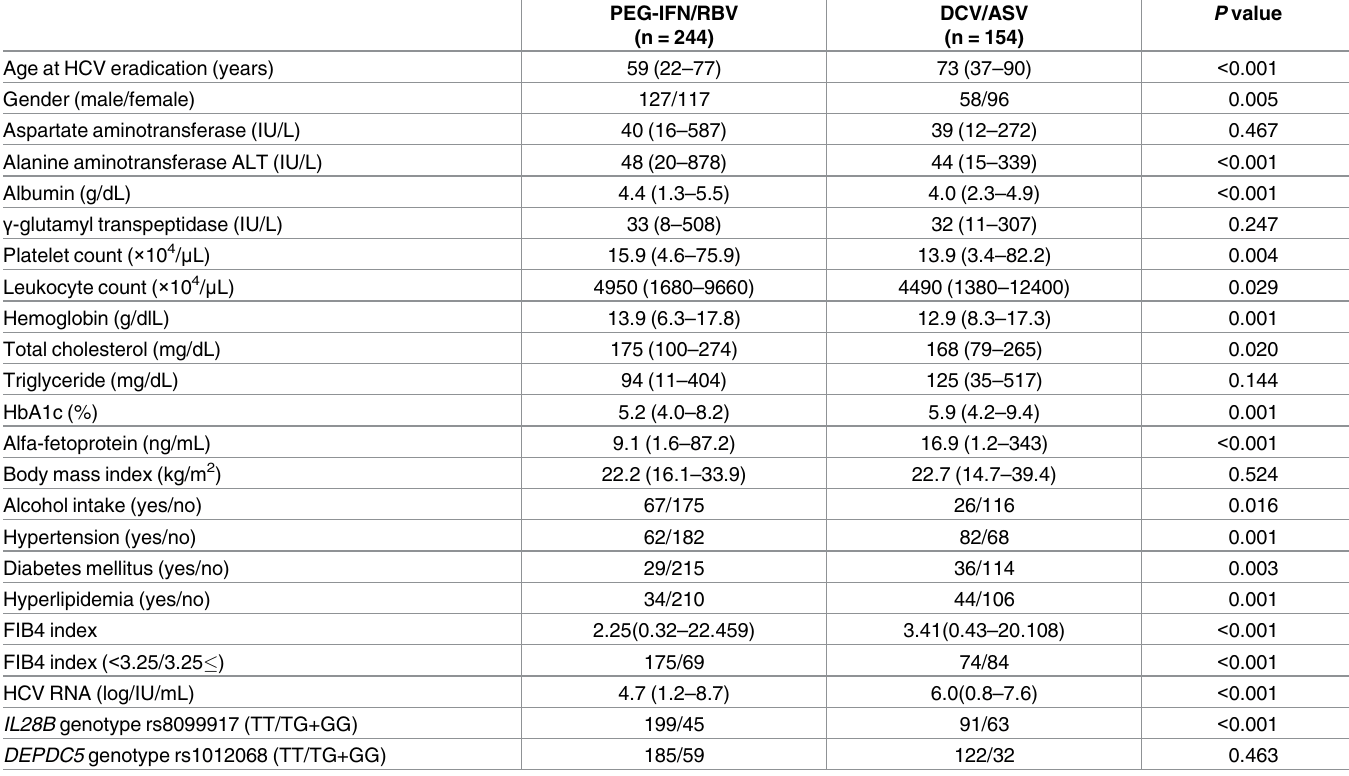
Table 1. Clinical characteristics of 398 patients.